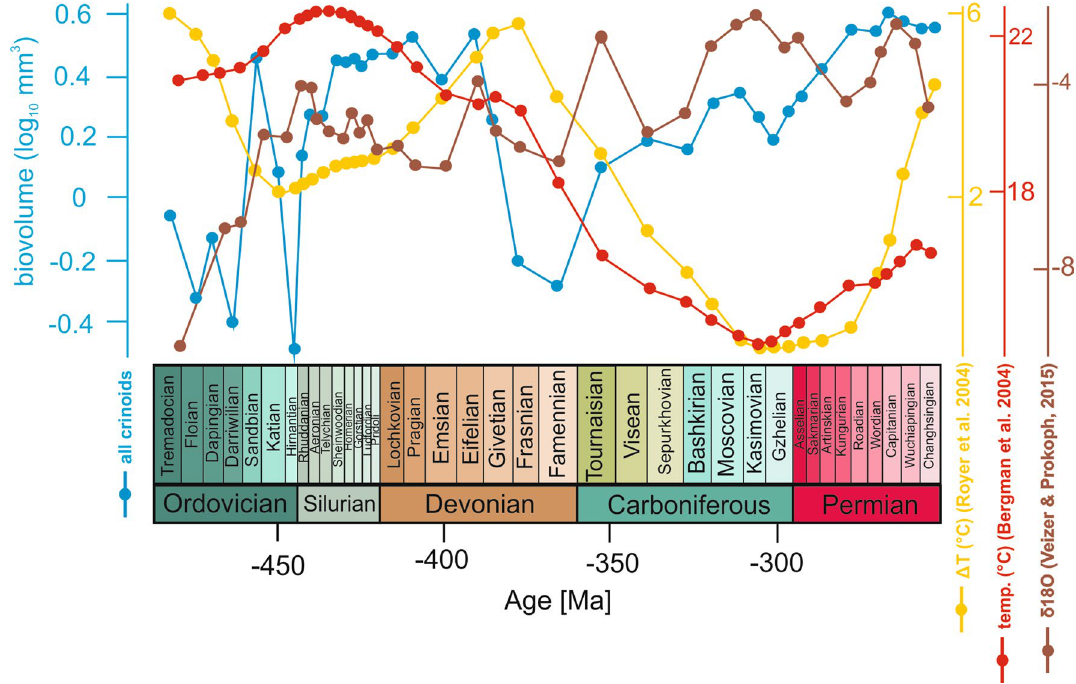
Figure 4. Mean calyx size of crinoids as a whole in the Palaeozoic plotted with temperature and δ18O curves inferred from three different